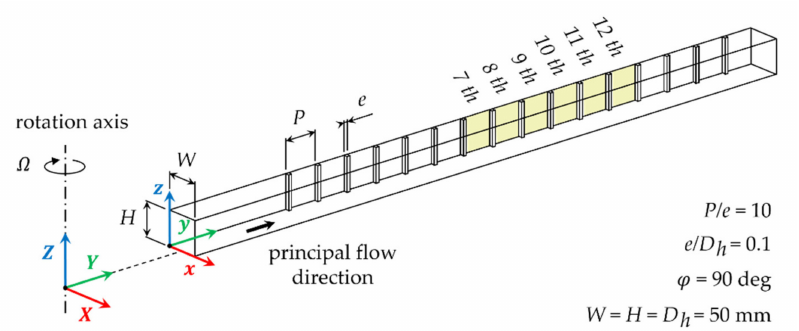
Figure 1. Sketch of geometry and coordinate system of the test